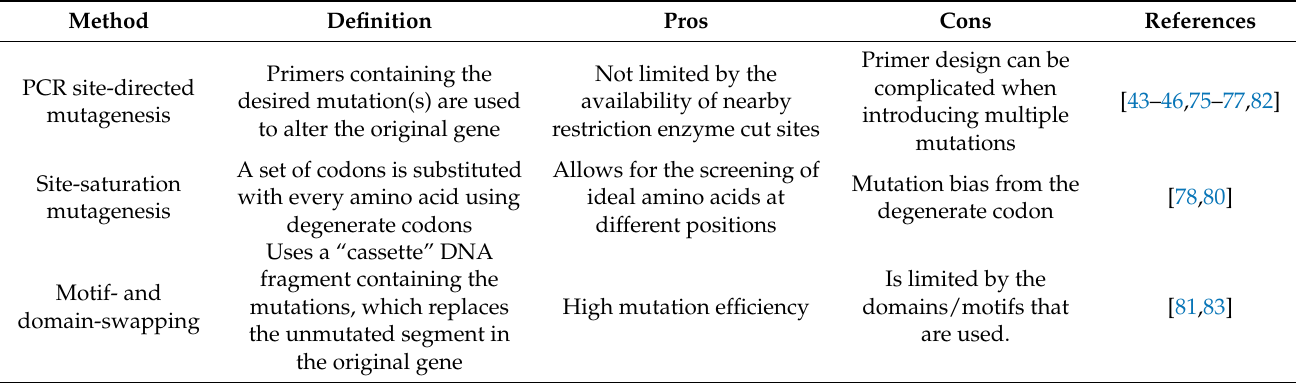
Table 3. Overview of site-directed mutagenesis